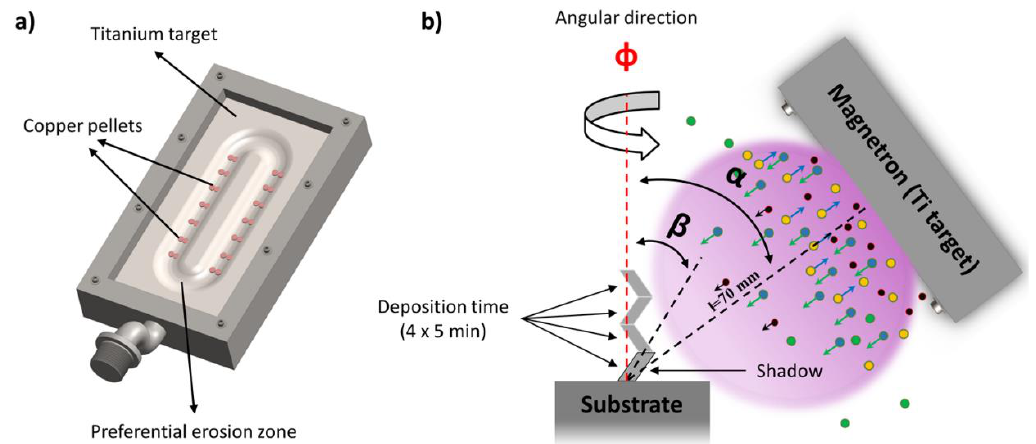
Figure 1. ( a ) Representation of the distribution of the Cu pellets on the Ti target; ( b ) α is the applied angle of the substrate relative to the Ti particle flux, β is the chevron growth angle, Φ is the angular direction and l = 70 mm is the distance between the target and the substrate.